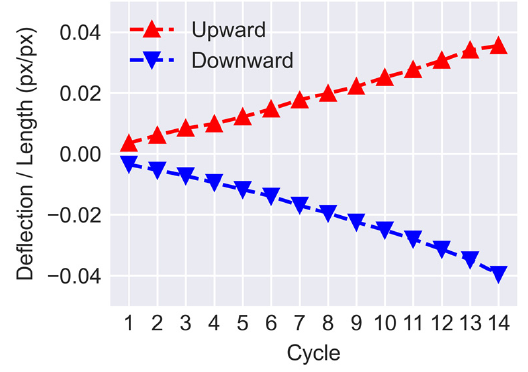
Figure 16. Deflection ratio of the concrete